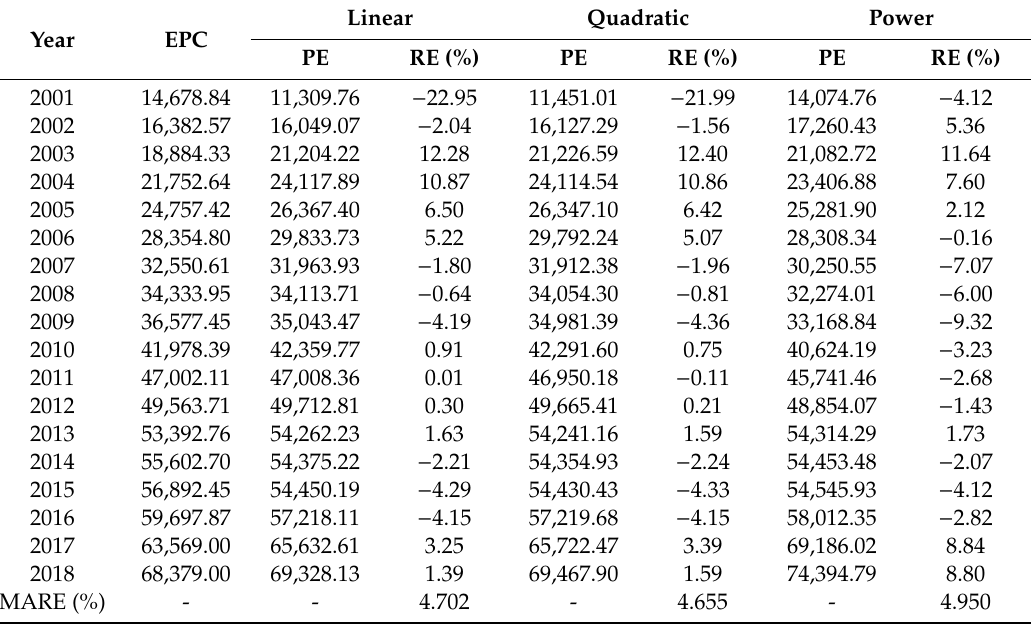
Table 2. Accuracy of the estimated statistical electric power consumption (EPC) on time series at the national scale through the three regression models. Note: EPC represents the statistical electric power consumption, PE represents the predicted EPC, RE represents the relative error in percentage, and MARE represents the mean absolute relative error in percentage. The unit of EPC is billion · kilowatt · h − 1 . Year